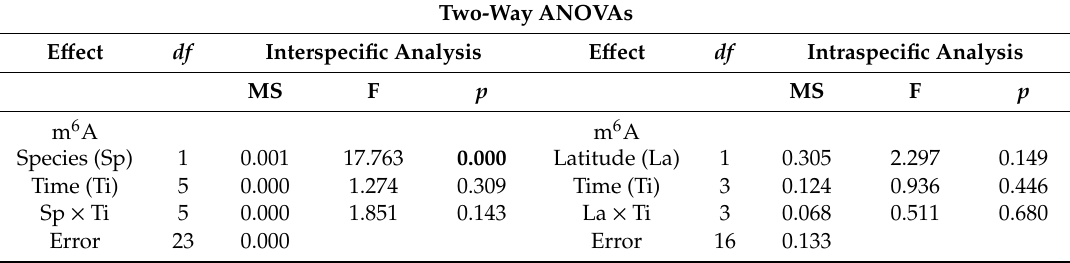
Table 5. Results of two-way ANOVAs conducted on the global N 6 -methyl-adenosine (m 6 A) level for inter- ( C. nodosa vs. Z. marina ) and intraspecific ( Z. marina at di ff erent latitudes) comparisons. p < 0.05 are in